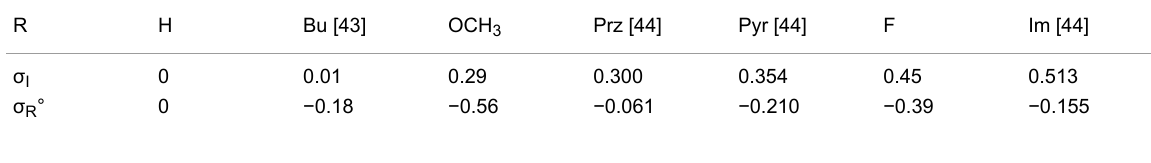
Table 5: The substituent electron parameters of some R in RC 6 H 4 F (in CDCl 3 ) [42]. R H